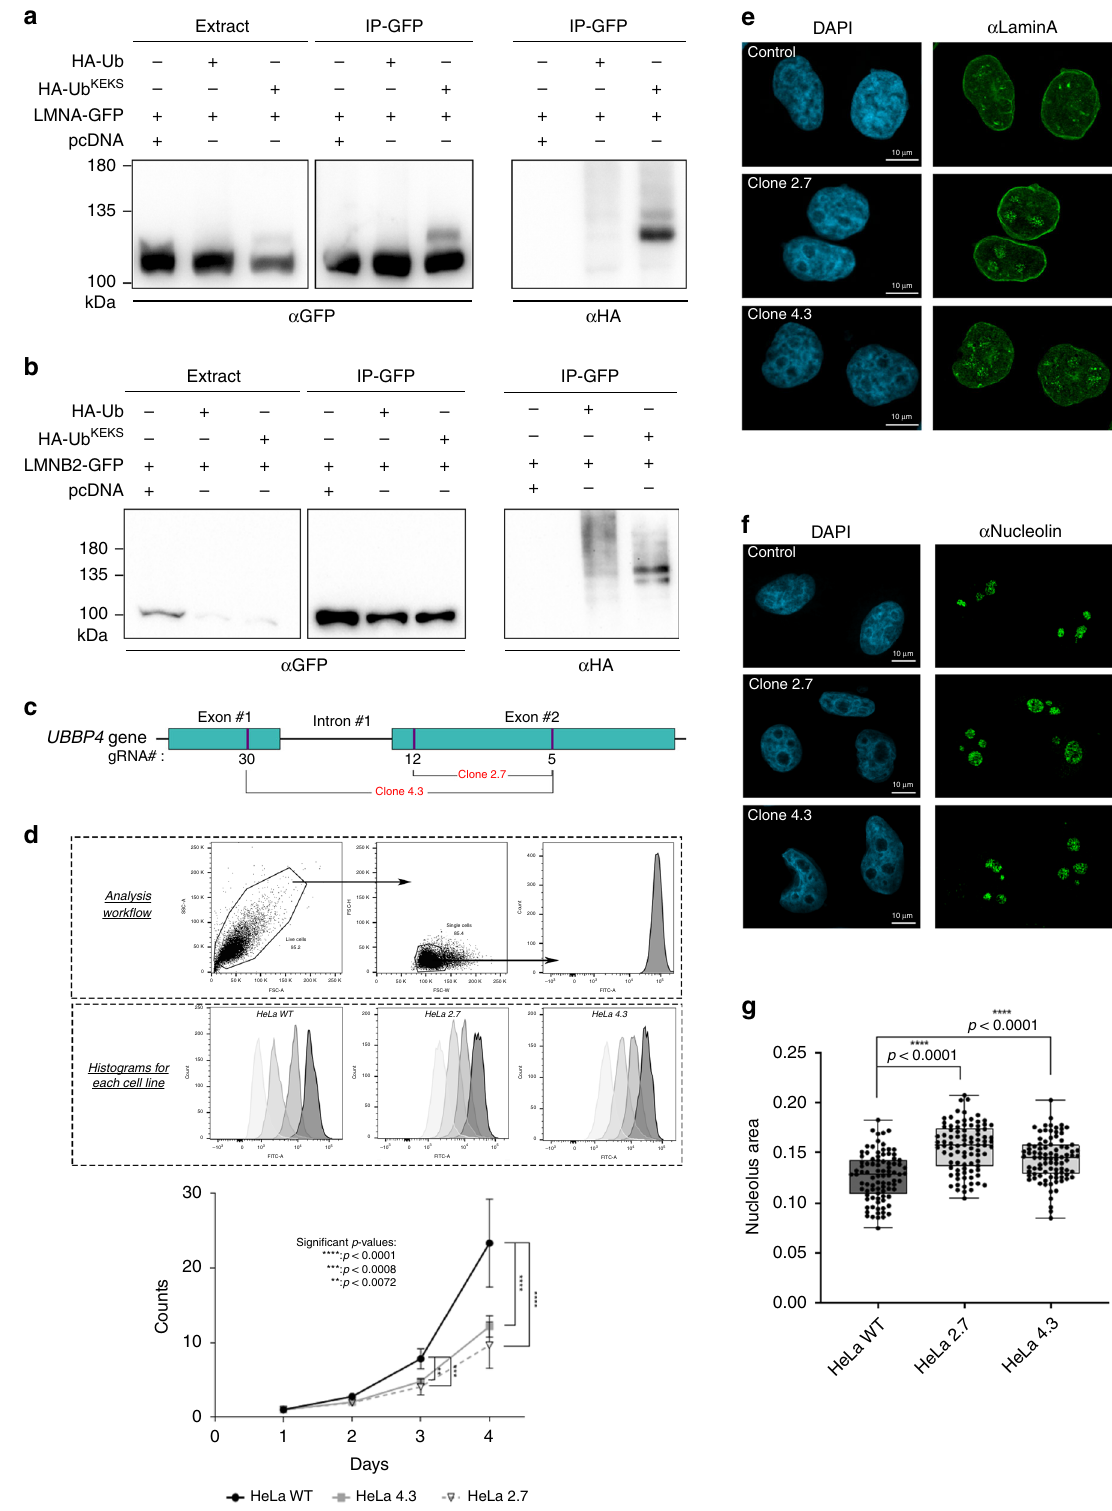
AQUA method 51 . There are four unique peptides for Ub KEKS that have been detected in several large-scale studies (Fig. 2b) 39 – 46 . Of those, three have miscleavages and included the N-terminal methionine which is often found modi fi ed (see peptide sequences in Fig. 2b). This left only one peptide that had no miscleavage, no internal lysine or arginine and was detected in fi ve